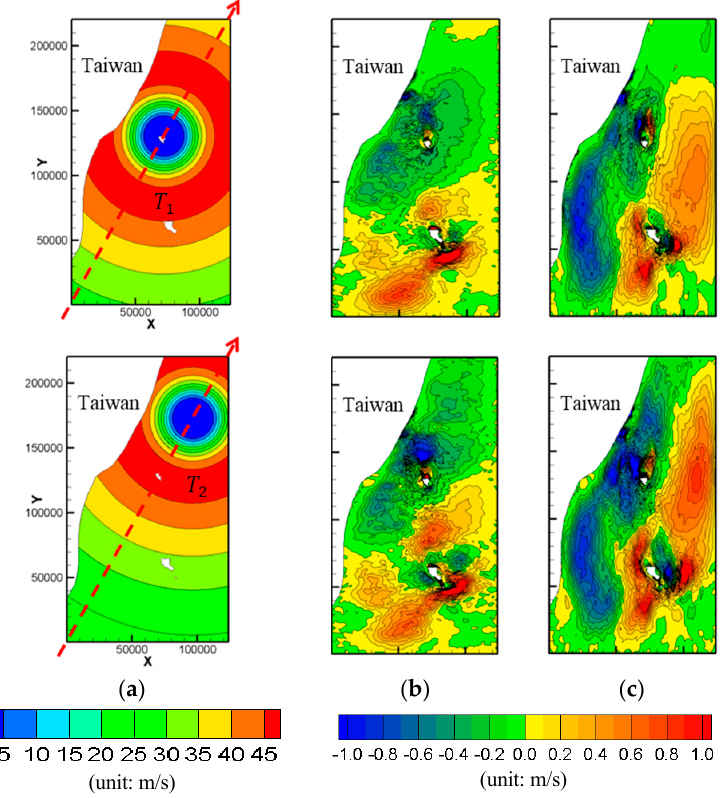
Figure 10. Contours of ( a ) W 10 , “net” ( b ) u -, and ( c ) v -contours of (unit: m/s) SN typhoon with moving speed W T = 2.5 m/s at T 0 – T 2 three time instances indicated by the three vertical lines of Figure 16a.